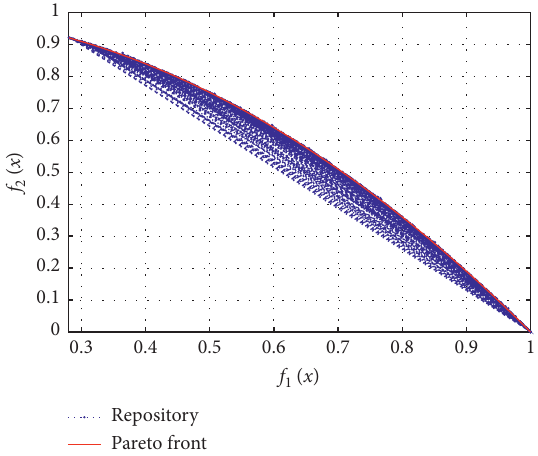
Figure 7: Pareto front produced by MOLFA for the ZDT6 test function. Table 2: Results of GD, SP, and ER metric for the test problems. GD SP ER